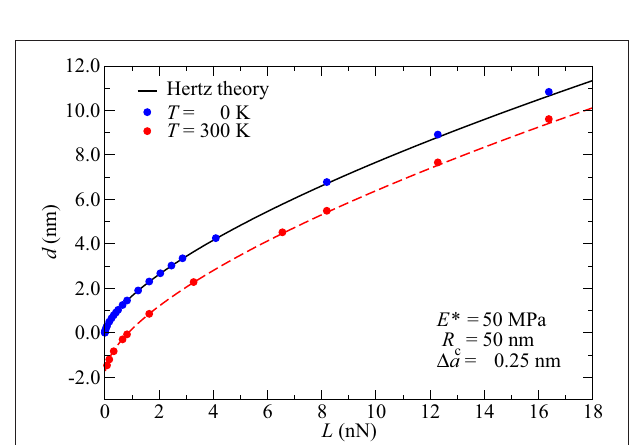
FIGURE 8 | Displacement as a function of temperature at fixed load for a moderately hard-matter ( left , E ∗ Symbols indicate the results from GFMD simulations, while blue and red lines represent the low-temperature and intermediate-temperature approximations, respectively.